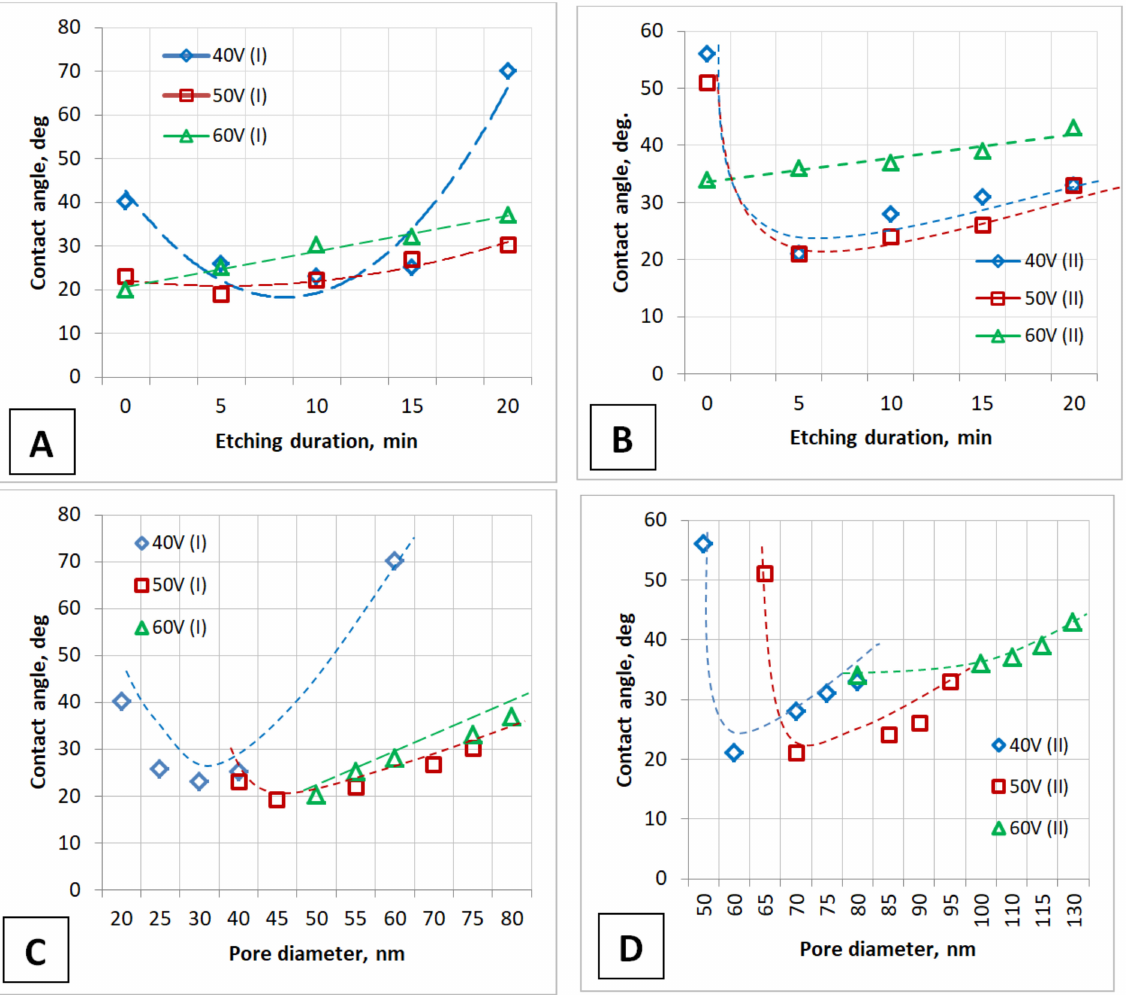
Figure 10. The dependence of the contact angle on the PAA pore diameter and etching duration of the barrier layer obtained during one-stage ( A , C ) and two-stage ( B , D ) anodizing after chemical modification (after 1 min the water drop